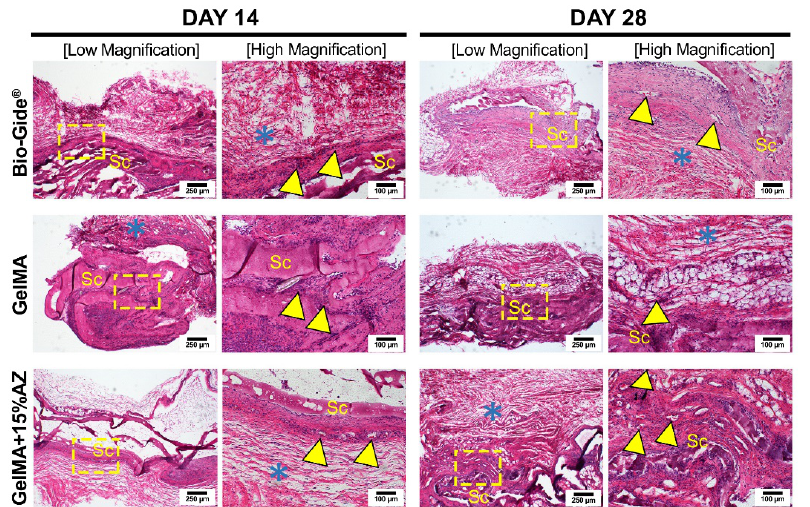
Figure 5. H&E-stained slices for implanted materials in rats’ subcutaneous tissue at 14 and 28 d. 4X magnification (scale bar = 250 µ m) and 10X magnification (scale bar = 100 µ m). A dashed yellow square delimits the area selected for higher magnification. Scaffold: Sc, Blood vessels: yellow arrowhead, Fibroblasts with collagen fibrils: blue asterisk. Note at 14 d, the enhanced inflammatory reaction evoked by pure GelMA, compared to the other two groups, and higher blood vessel formation and well-oriented collagen fibers from the group GelMA+15%AZ at 28